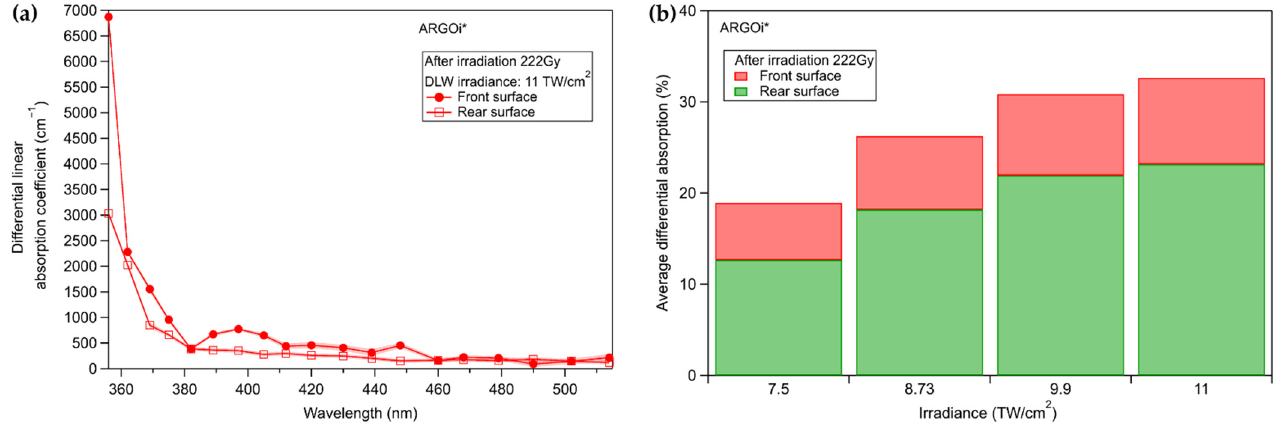
Figure 9. ( a ) Differential linear absorption coefficient of the laser-inscribed structures (11 TW/cm 2 ) for the two planes after irradiation at 222 Gy X-ray dose in the ARGOi* glass sample. ( b ) Average differential absorption of the inscribed structures for all DLW irradiance (as from Figure 9a).